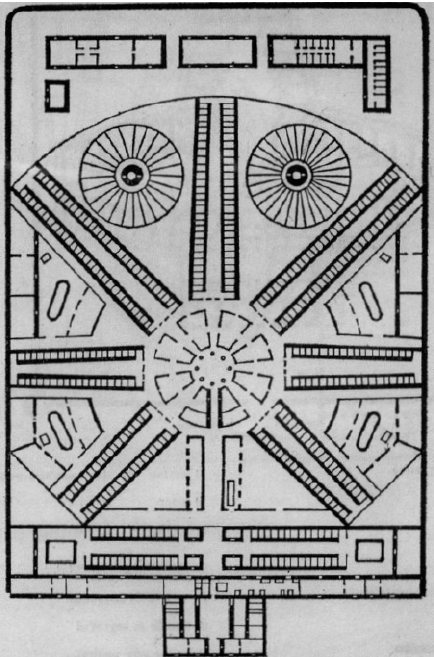
Figure 1. Antonio Torres Torija, overall distribution plane of the prison ground floor [9].